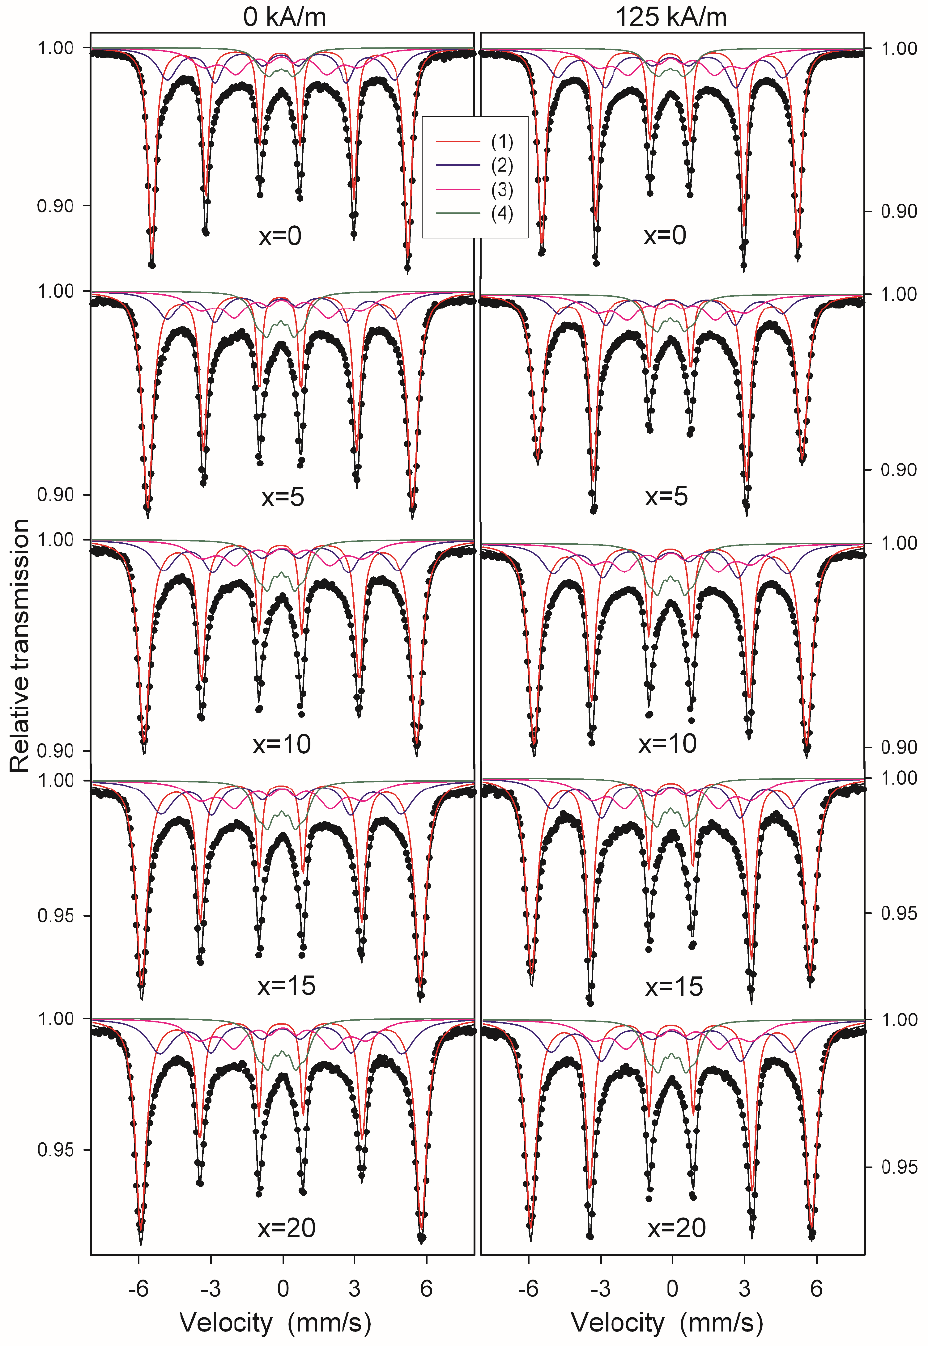
Figure 13. Mössbauer spectra of Fe 84.5 − x Co x Nb 5 B 8.5 P 2 alloys annealed at 525 °C for 20 min without (left column) and with (right column) the magnetic field of 125 kA/m.